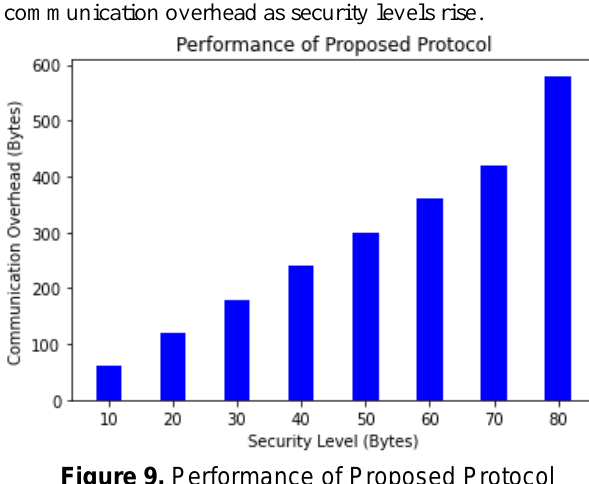
Figure 9. Performance of Proposed